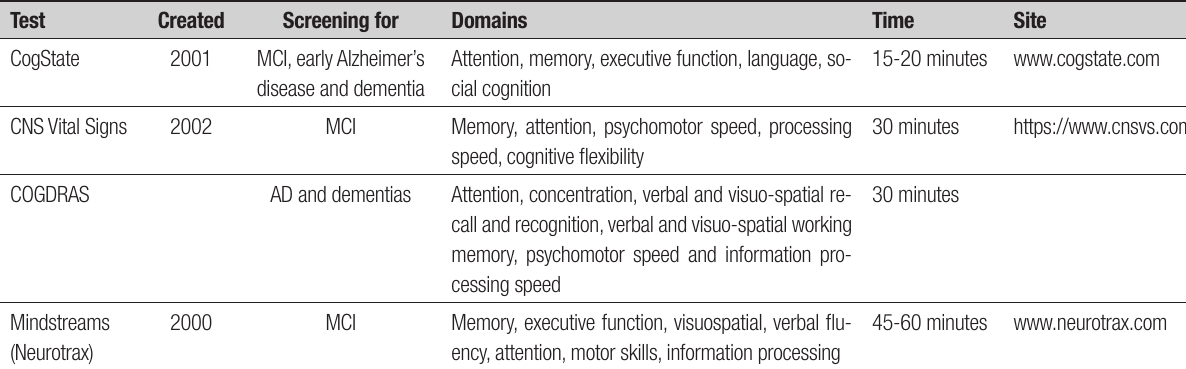
Table 2. Main characteristics of the computerized